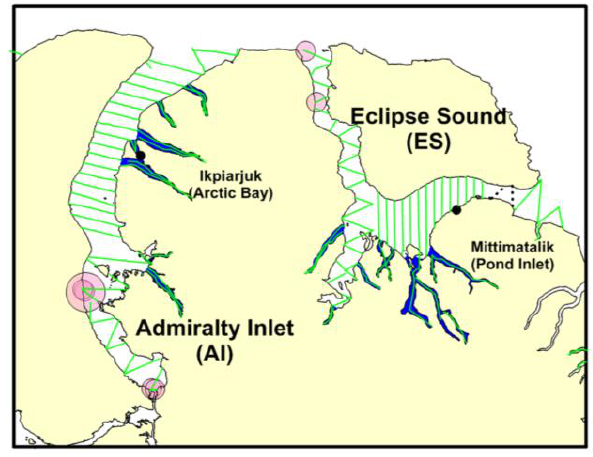
Figure 4. Admiralty Inlet and Eclipse Sound showing completed transects (green), un-completed planned transects (black dashed) and sightings of bowhead whales with symbol size proportional to group size (1 – 2). Surveyed fjord strata: blue. Transect design was performed using Distance version